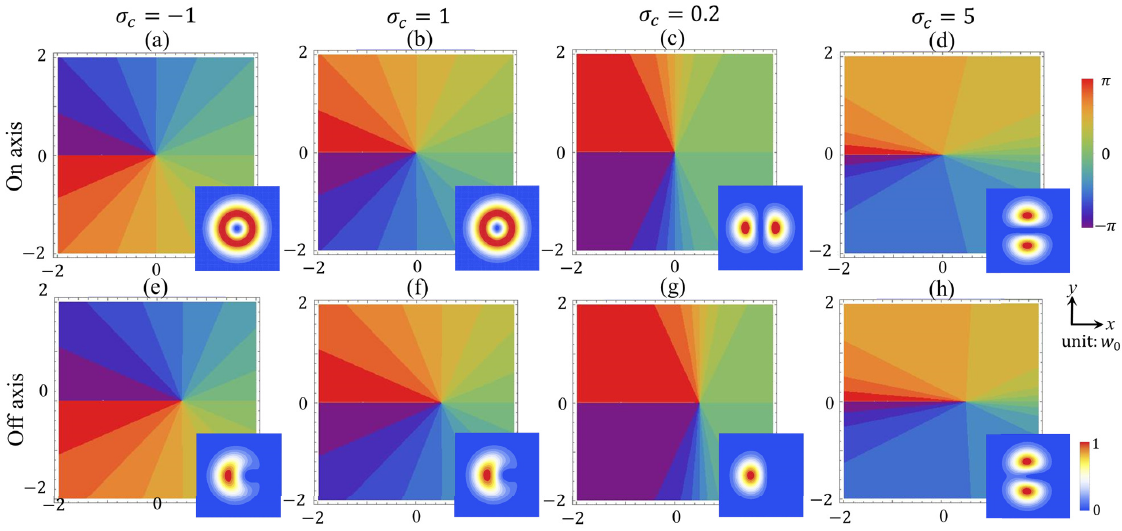
Figure 1. Structure of noncanonical vortex. The big plots are phase distributions and the inserts are their corresponding intensity distributions. In the first row, the vortex is located at the beam center, and in the second row, it is off-axis with a = 0.5 w 0 . In the left two columns σ c = ± 1 [( a , b , e , f )], i.e., the vortex degenerates into the canonical